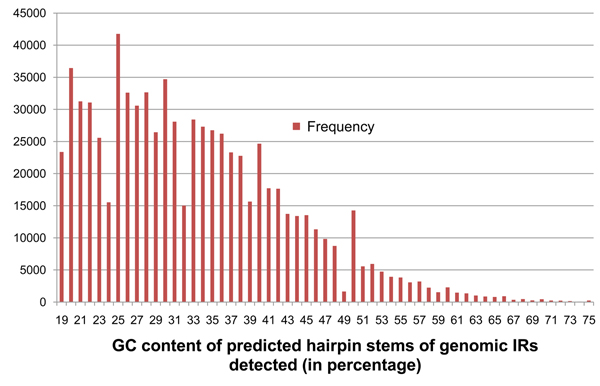
Frequency distribution of parameter G on genomic At IRs. Shows the frequency distribution of GC content density (G) in IRs detected from genomic DNA of Arabidopsis thaliana with base thresholds of Dmin = 59% and Pmax = 9.99×10-9, Amin = 2.0, and Gmin = 19. The values of G for each pre-miRNA IR has been floored to the closest whole number lesser than it.